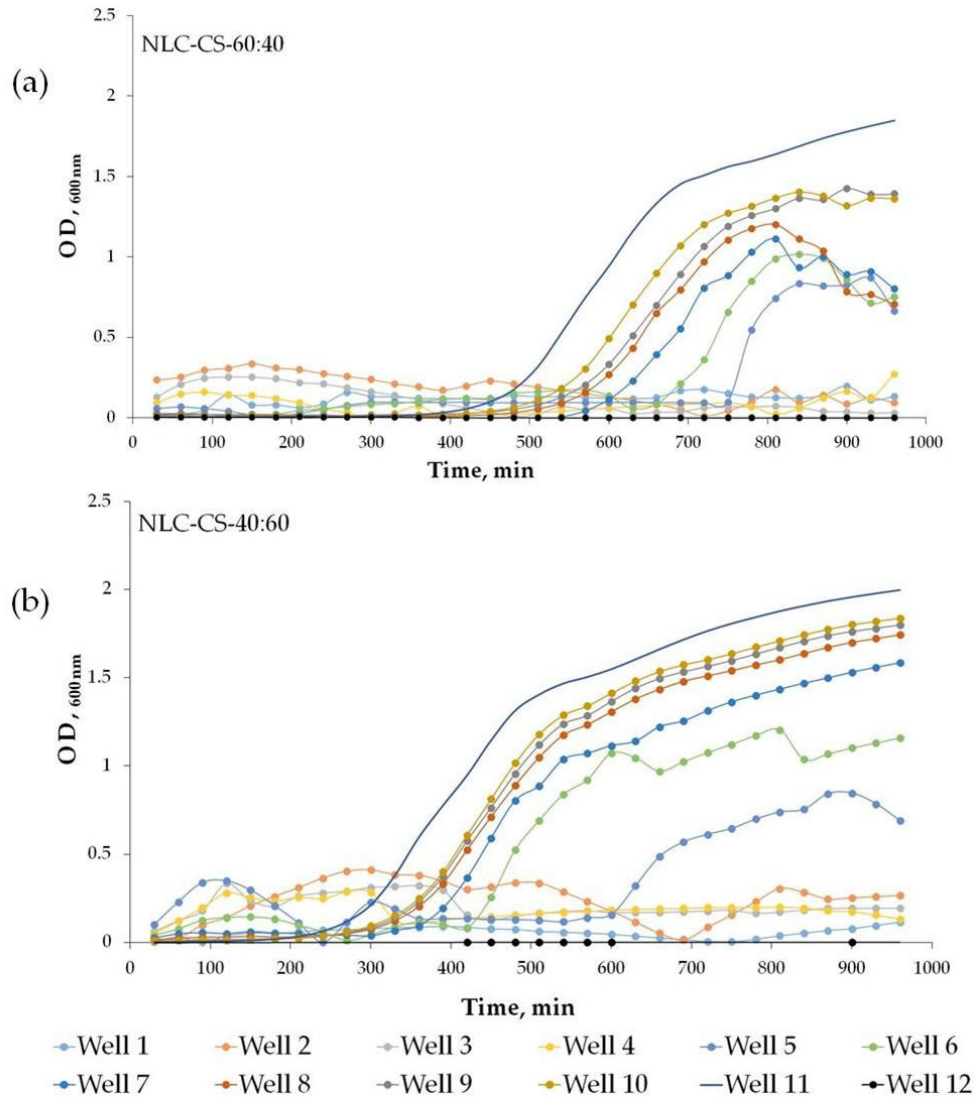
Figure 10. S. aureus growth in the presence of NLC-CS for ( a ) SL:LL = 60:40 and ( b ) SL:LL = 40:60 ratios; S. aureus : 5 × 10 3 cells/well, incubation at 37 °C, with constant shaking for 16 h, OD 600 nm was measured every 30 min. Each experiment was repeated in triplicate.